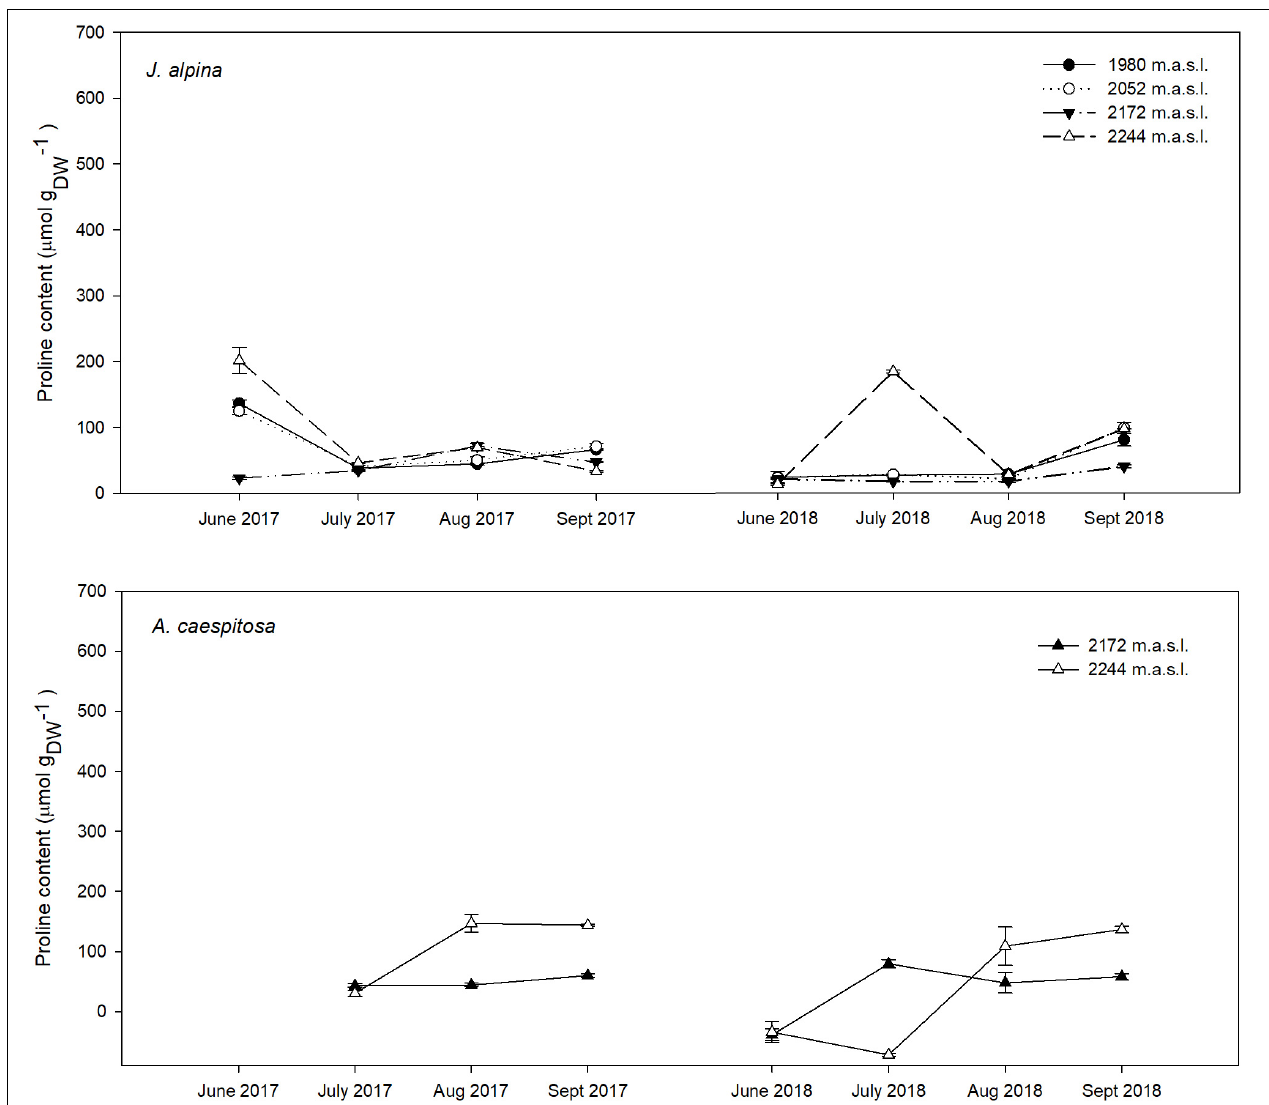
FIGURE 2 | Seasonal variation in Pro content in the studied chamaephytes (dwarf shrubs), J. alpina, and A. caespitosa at each sampling site and throughout their active growing season in 2017, 2018. For each sampling event, n =